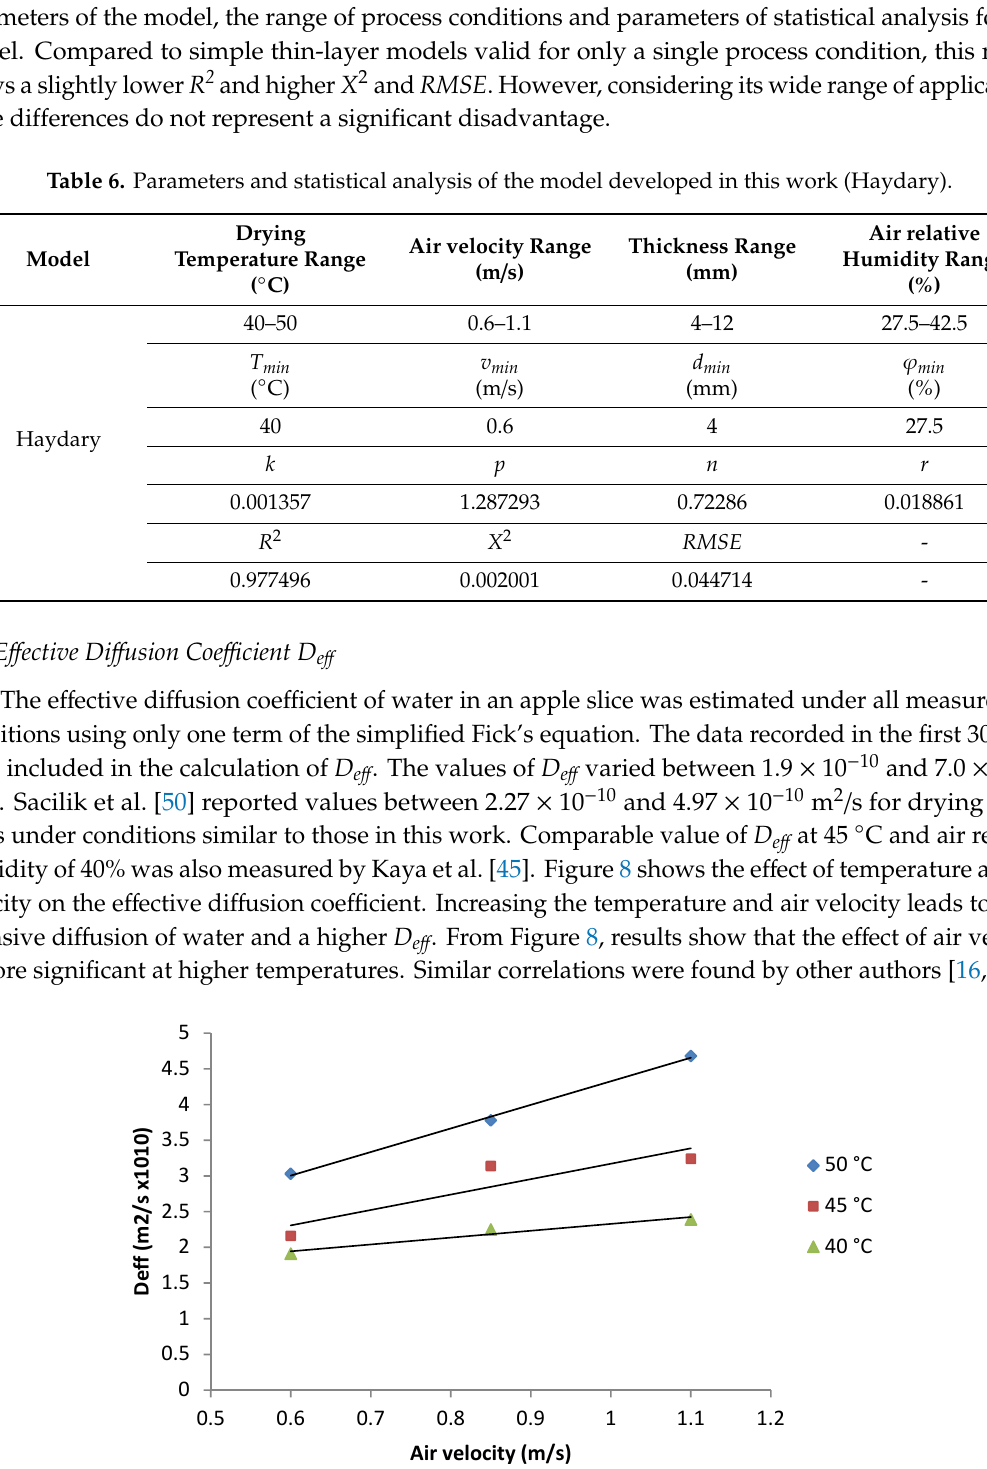
Figure 8. E ff ective di ff usion coe ffi cient vs. temperature and air Figure 8. Effective diffusion coefficient vs. temperature and air velocity.